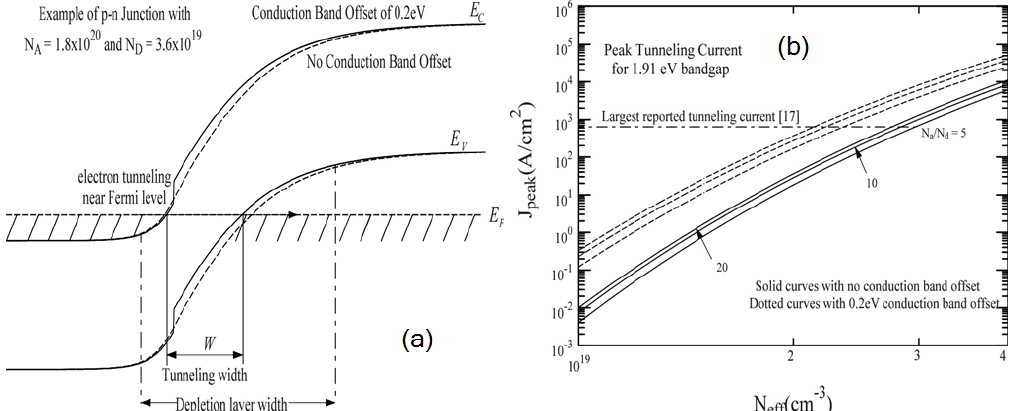
Figure 5. ( a ) Example of junction tunneling width and depletion layer width and ( b ) Peak tunneling current for model 1.91 eV band gap tunneling junction [45].